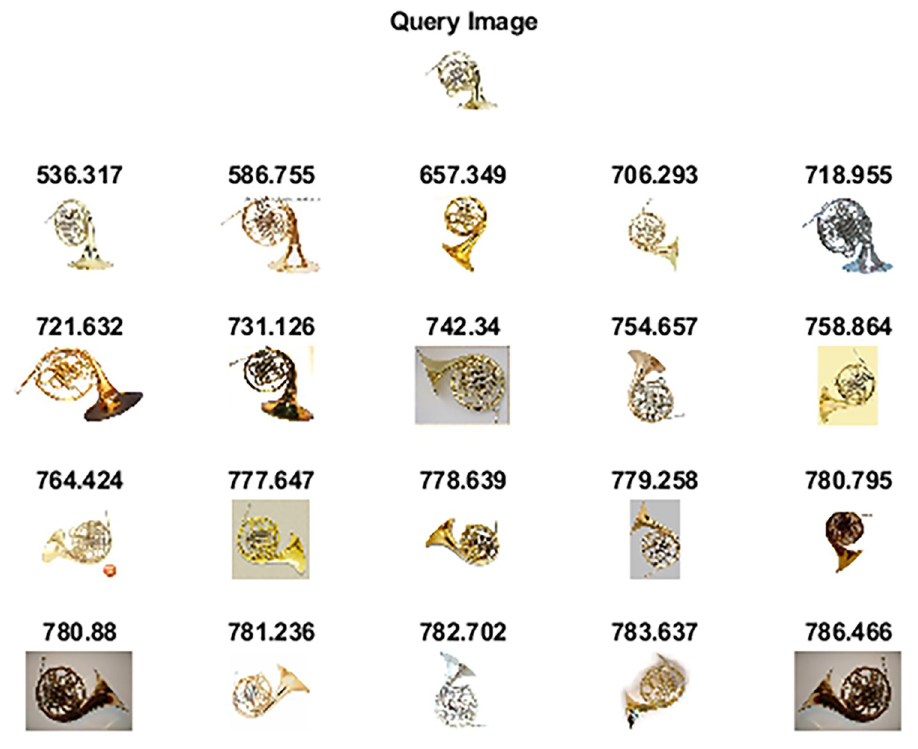
Fig 19. Top-20 retrieved images according to the query image of the Caltech-256 dataset (class: French Horn).